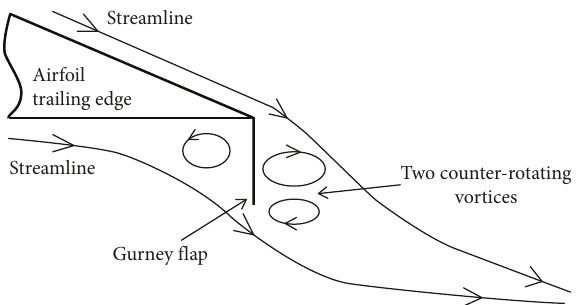
Figure 1: Hypothesized Gurney fl ap trailing-edge fl ow conditions of an airfoil.